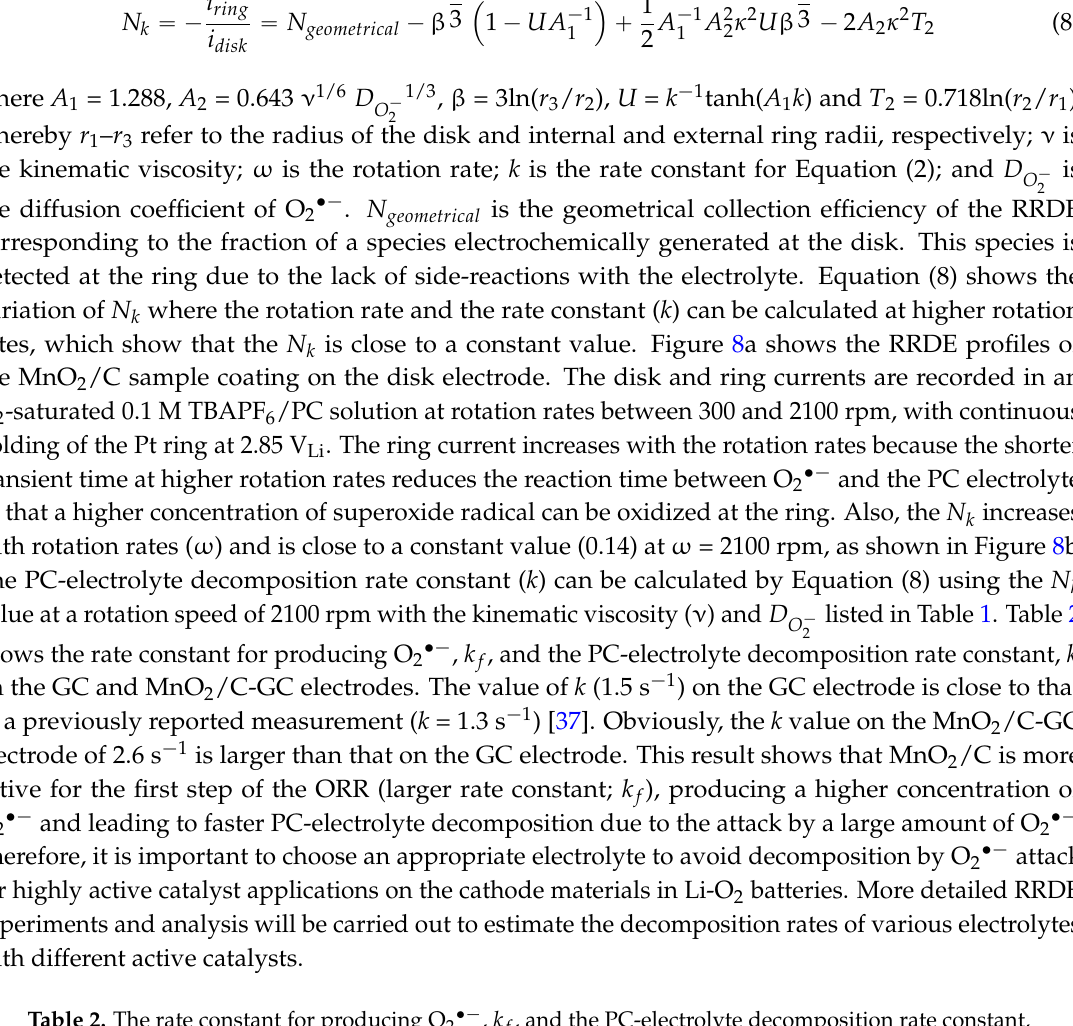
Table 2. The rate constant for producing O 2 ‚´ , k f , and the PC-electrolyte decomposition rate constant, k , on the GC and MnO 2 /C-GC